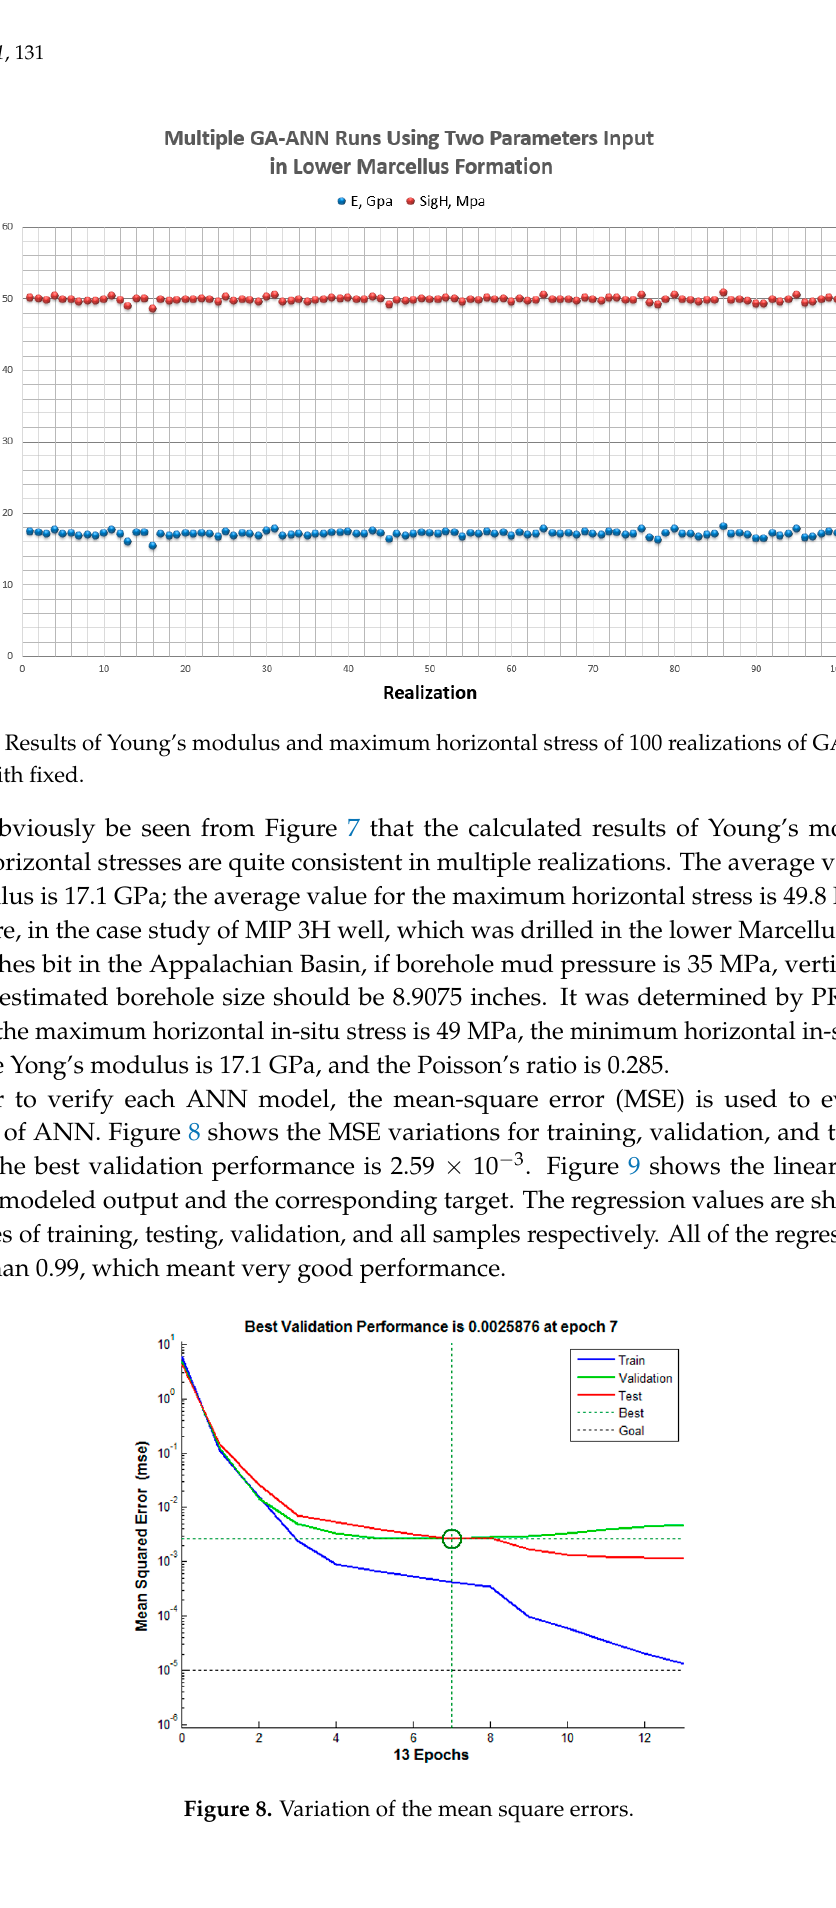
Figure 8. Variation of the mean square errors.